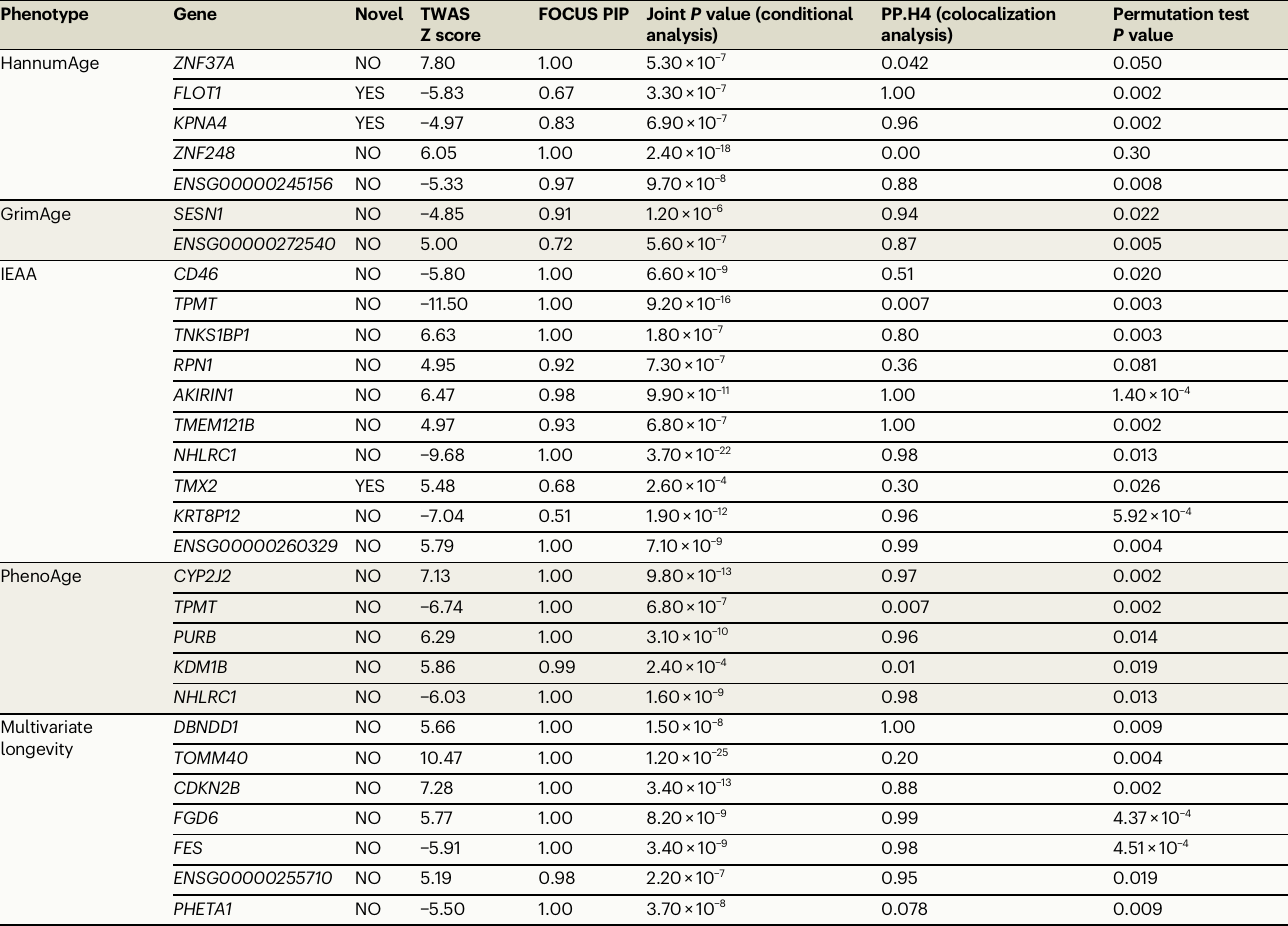
Table 1 | High con fi dence genes associated with aging phenotypes (TWAS signi fi cant, conditionally signi fi cant, and PIP > 0.5)